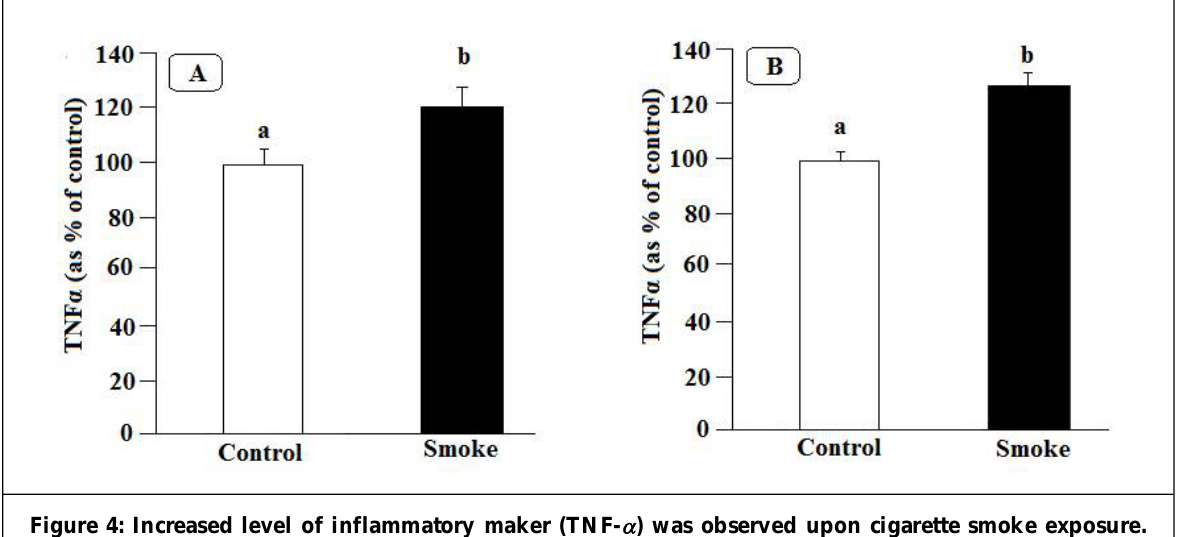
Figure 4: Increased level of inflammatory maker (TNF-  ) was observed upon cigarette smoke exposure. Effect of cigarette smoking on the levels of tumor necrosis factor alpha (TNF-  ) in the plasma (A) and lung tissues (B). Results are mean ± SE ( n = 5). Bars with different alphabets are significantly different at p <